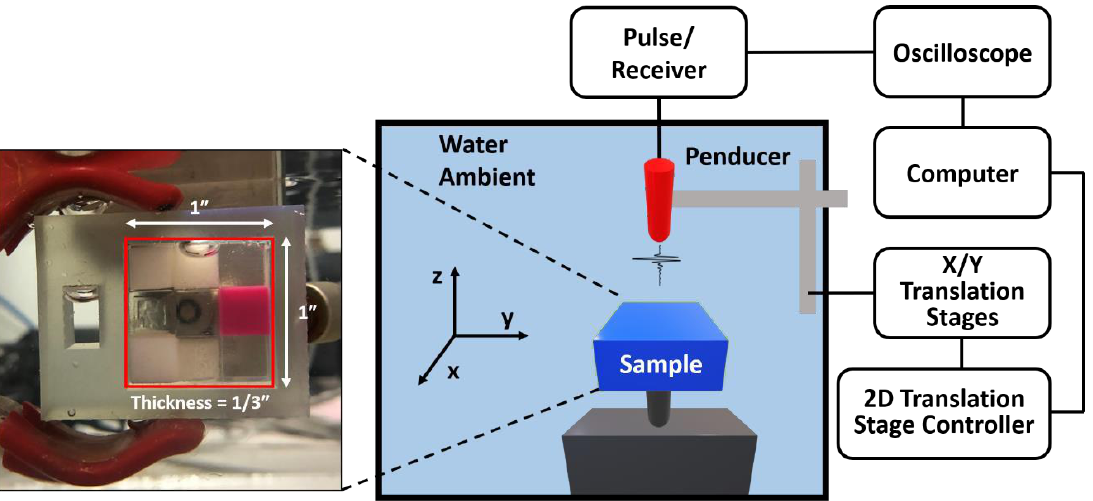
Figure 3. The schematic of the experimental setup of the dynamic bulk modulus elastography (EBME) raster scan and the dimension of the printed sample. The sample has Rubik’s cube-like shape with 9 different materials. The sample was printed by J750 DAP of Stratasys.